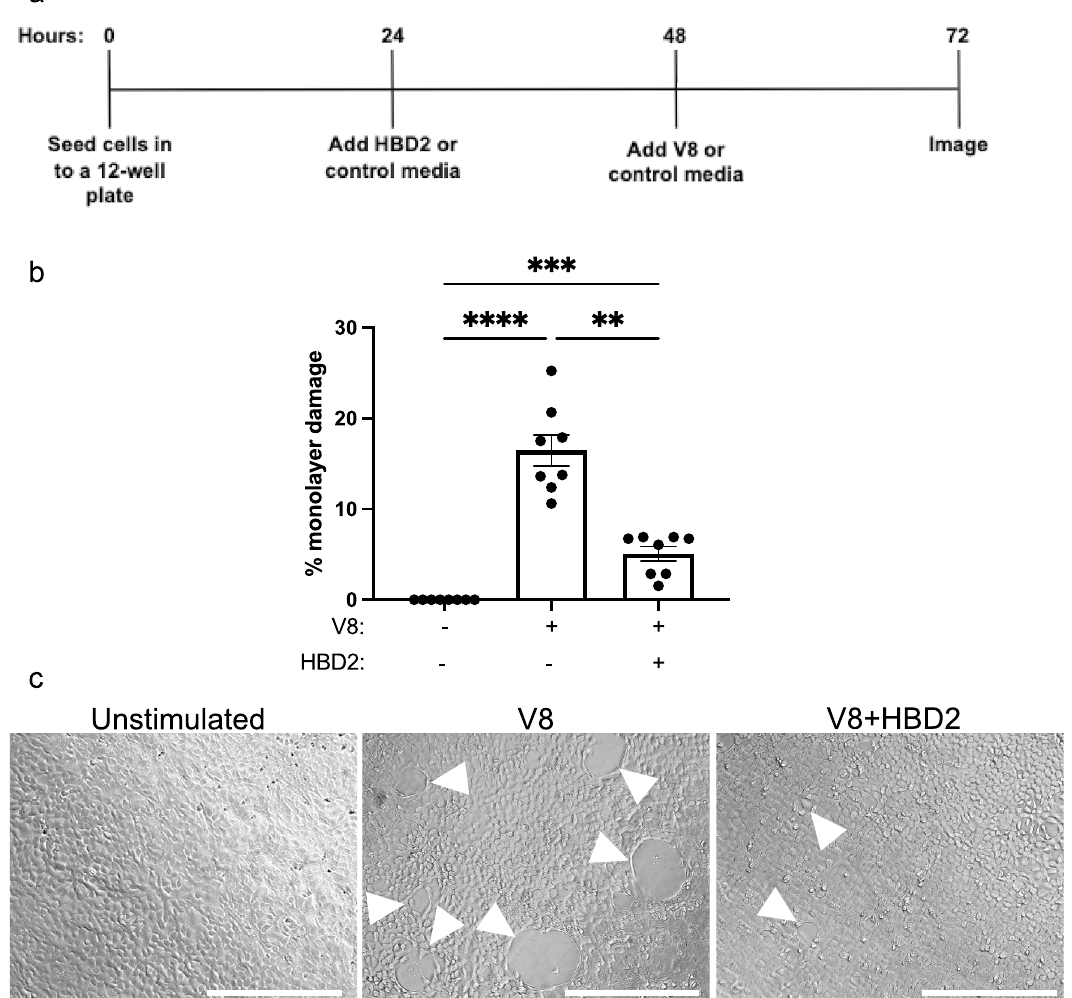
Figure 1. HBD2 protects against V8-mediated barrier integrity damage. ( a ) Timeline of damage assay, with treatment conditions indicated. ( b , c ) HaCaT cells were treated with 0.5 µg/ml HBD2 or vehicle control for 24 h. Recombinant V8 (5 µg/ml) or PBS (vehicle control) was then added, and cells were incubated for a further 24 h before 5 random fields of view were imaged per condition by phase contrast microscopy. ( b ) Quantification of V8-mediated damage represented as % monolayer damage. Data shown as mean ± SEM for n = 8. Statistical analysis by paired one-way ANOVA with Repeated Measures (RM) multiple comparisons post-test. ** p < 0.01 *** p < 0.005 **** p < 0.001. ( c ) Representative images of damage at 72 h (from n = 8), with barrier integrity damage “holes” indicated with white arrow heads. Scale bar represents 200